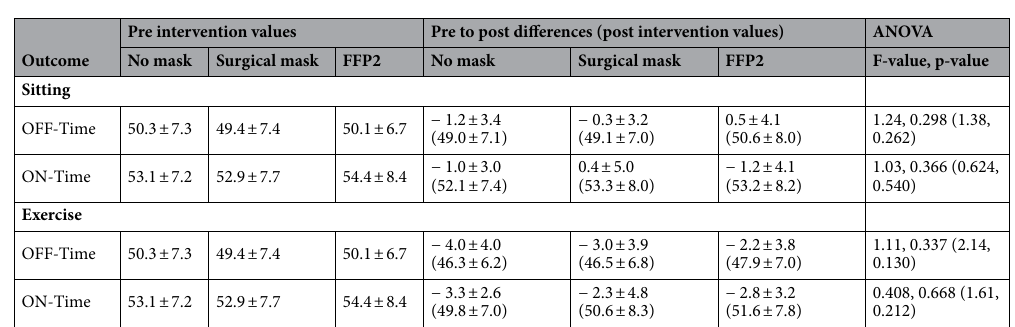
Figure 3. Mean values and 95% confidence intervals for systolic blood pressure, capillary blood carbon dioxide partial pressure and pH during exercise with no mask, a surgical mask or a filtering face piece type 2 (FFP2) and pre- to post exercise changes in cognitive attention (Stroop OFF-Time) and executive function (Stroop ON-Time) performance in seconds. Asterisks symbols (*) indicate significant time effects; Hash symbols (#) indicate significant pre to post exercise change in cognitive performance.